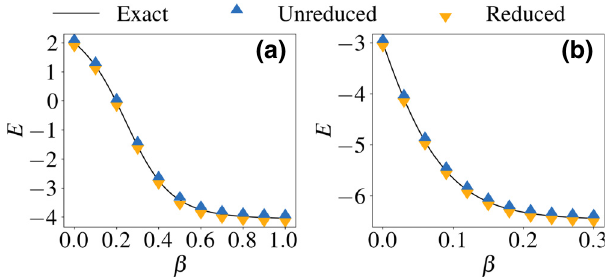
FIG. 2. Energy E versus imaginary time β simulated with- out noise or measurement sampling on a single initial state with and without reduction of the Pauli strings in the QITE unitaries by Z 2 symmetries. (a) Four-site TFIM with J = h = 1 and ini- tial state | 0001 (cid:7) . The imaginary-time-step size in QITE is set to (cid:3)τ = 0.01. The number of Pauli strings from three D = 2 domains is reduced from 16 to 6 by one Z 2 symmetry Z 0 Z 1 Z 2 Z 3 . (b) Four-site Heisenberg model with J = (cid:3) = 1 and initial state √ ( | 0101 (cid:7) + | 1010 (cid:7) ) / 2. The imaginary-time-step size in QITE is set to (cid:3)τ = 0.03. The number of Pauli strings on the single D = 4 domain is reduced from 120 to 6 by two Z 2 symmetries Z 0 Z 1 Z 2 Z 3 and X 0 X 1 X 2 X 3 . In both panels the energy trajectories using reduced numbers of Pauli strings match the energy trajec- tories without reduction, which also match the energy trajectories from exact imaginary time